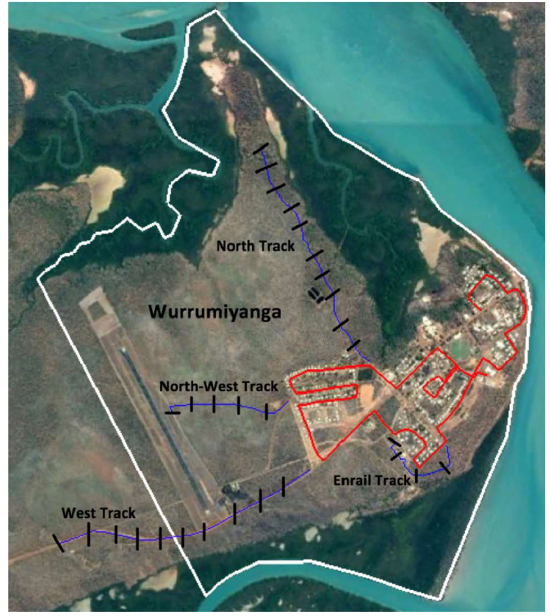
Figure 1. Wurrumiyanga, NT, Australia showing the predetermined transect (red) for direct observations of cats and camera transects (blue) where cameras were placed (black) every 200 m along roads/tracks.